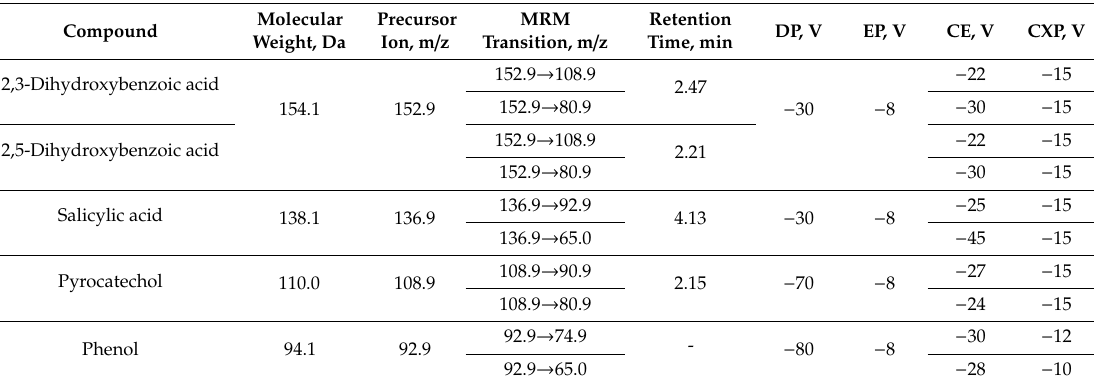
Table 2. Parameters optimized for the MS / MS